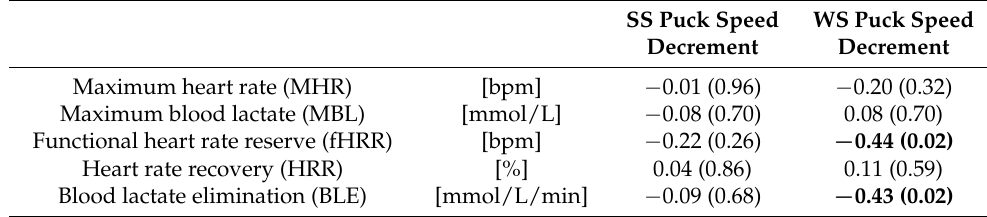
Table 4. Relationships between percentage slap shot (SS) or wrist shot (WS) puck speed decrement and indicators of players ( n = 27) physical capacity.